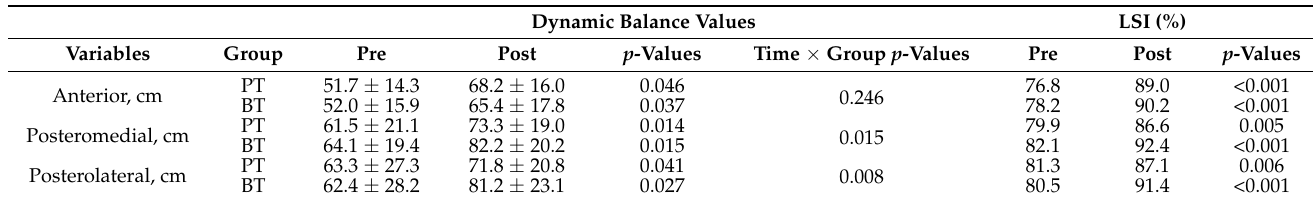
Table 5. Results of the Y-balance test for Pilates and balance training groups. Dynamic Balance Values